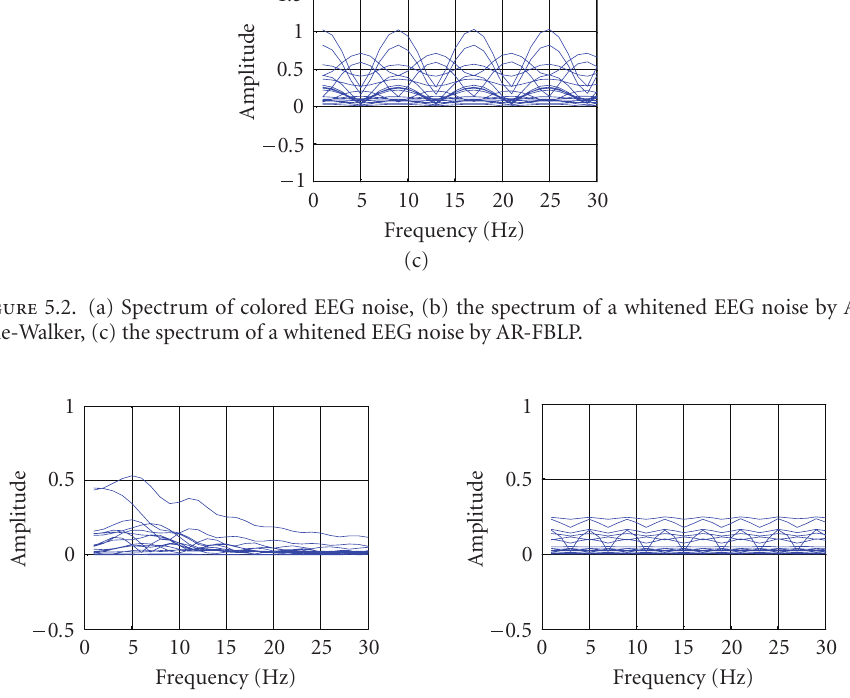
used to asses the whitening capabilities of the two parametric methods. The performance of the AR Yule-Walker and AR-FBLP in whitening colored noise is explored in time and frequency domains. Both algorithms show good potential in whitening the spectrum of the colored EEG noise with relatively better performance by